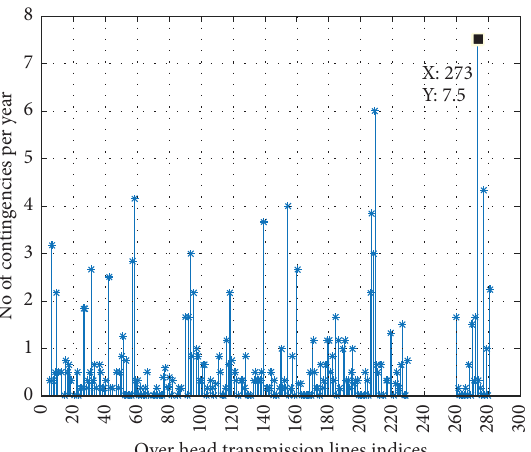
Figure 4: Mean failures per year for each line of the Khorasan network.